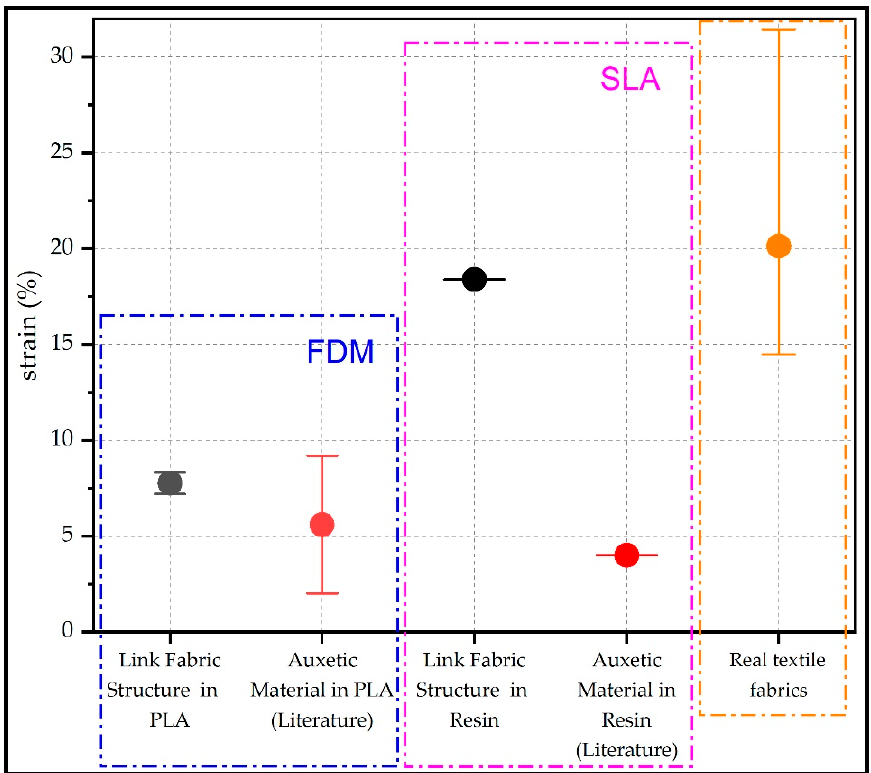
Figure 7. Comparison between the strains of the link fabric structure, the auxetic material and the real textile fabrics.